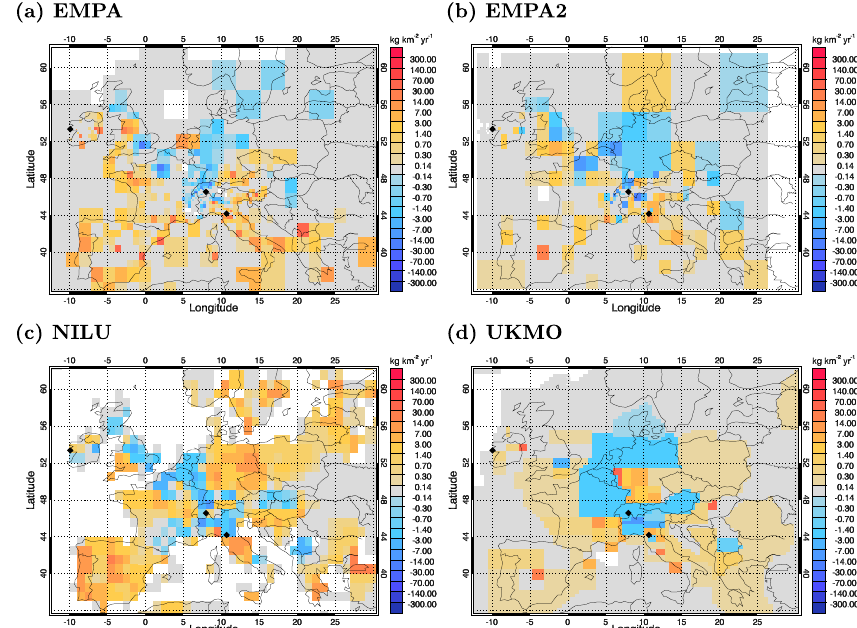
Figure 6. Posterior–prior HFC-125 emission differences (experiment M1).